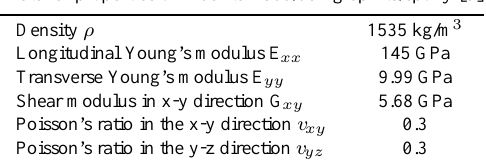
Table 1 Material properties of Fiberite T300/934 graphite/epoxy